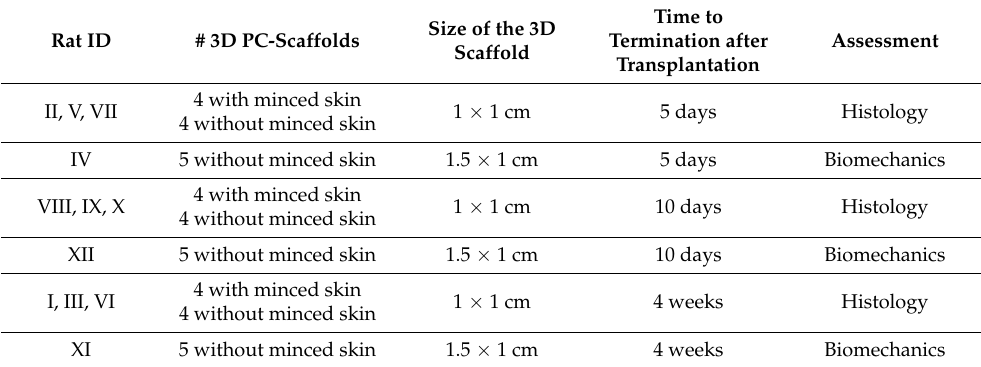
Table 1. Rat identity, type of 3D scaffold, size, and time of retrieval. In total, nine rats were used for histological evaluation and, additionally, three were used for mechanical evaluation.